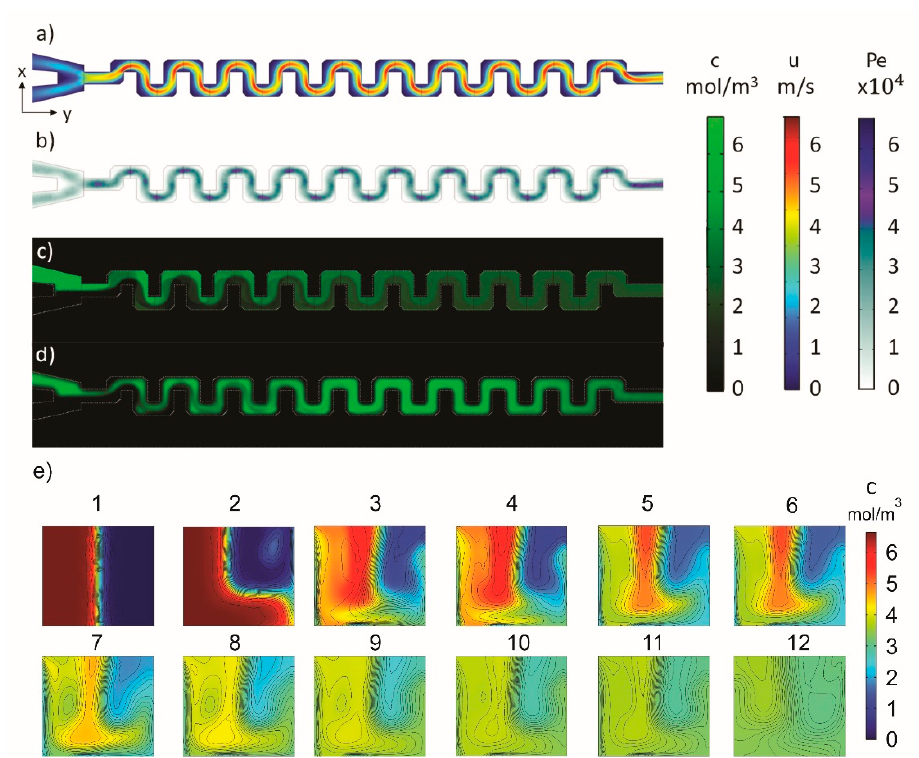
Figure 3. Distribution plots in the x–y plane at a flow rate of 80 µL/min for ( a ) velocity, ( b ) Peclet number, and ( c ) concentration. The intensity of the Peclet number (Pe) distribution in ( b ) directly corresponds to the intensity of the chaotic advection effect (chaotic mixing is higher in darker areas). The chaotic mixing of the two solutions is also apparent from the concentration distribution shown in ( c ). ( d ) An experimental optical fluorescence image of mixing in the serpentine, also at 80 µL/min, shows the same chaotic effect as was observed in the serpentine microchannel during simulations. Note that the outline of the channel is indicated by the dotted white line in ( c ) and ( d ). ( e ) shows the cross-sectional concentration distributions and iso-concentration contours as a function of distance travelled along the serpentine (at the 12 probe points which are indicated in Figure 2).